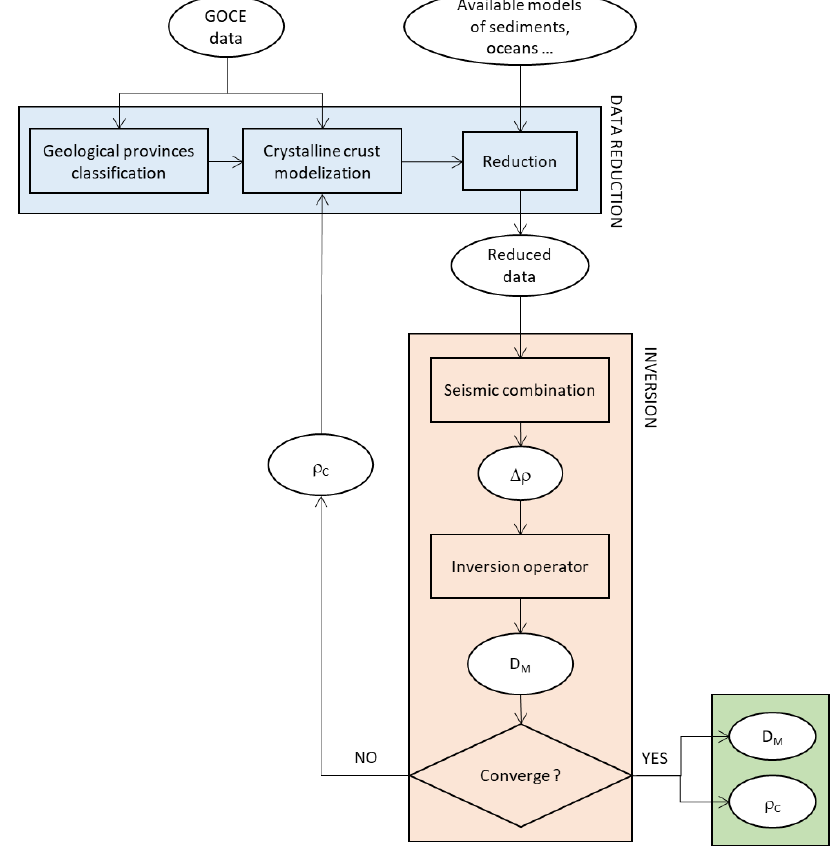
Figure 1. Computational core flow